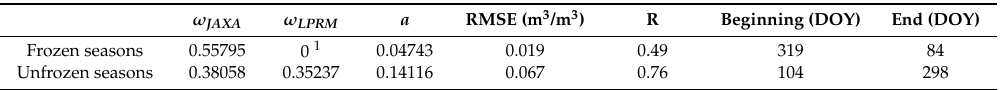
Table 1. Coefficients of the unfrozen seasons and frozen seasons.